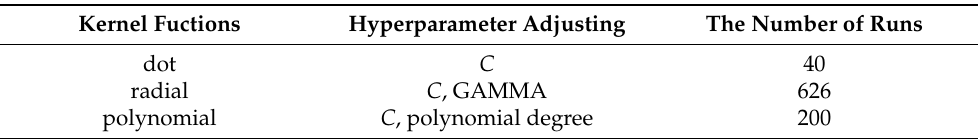
Table 7. Hyperparameters for each kernel function.